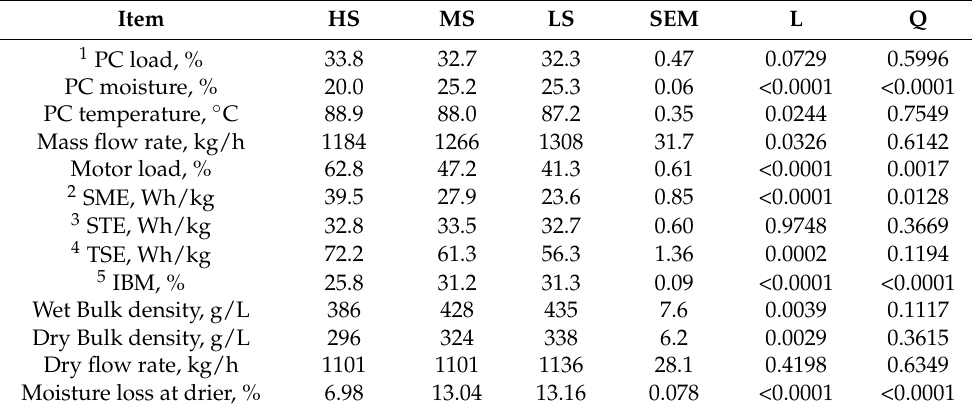
Table 3. Least square means and contrasts [linear (L); quadratic (Q)] for outputs from extrusion processing used to produce diets containing three levels of resistant starch. Item HS